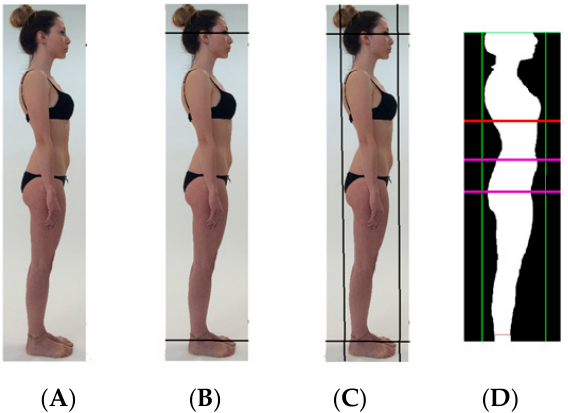
Figure 1. Images showing the sequence of operator-positioned and software-determined anatomical landmarks used to condition a digital photography lateral image. ( A ) Uploaded digital image of lateral surface of an individual; ( B ) operator-positioned horizontal lines at the level of the eyes and ankles; ( C ) operator-positioned vertical lines at widest protuberance of breast and hip; ( D ) software-determined horizontal lines at thorax, belly, and hips.